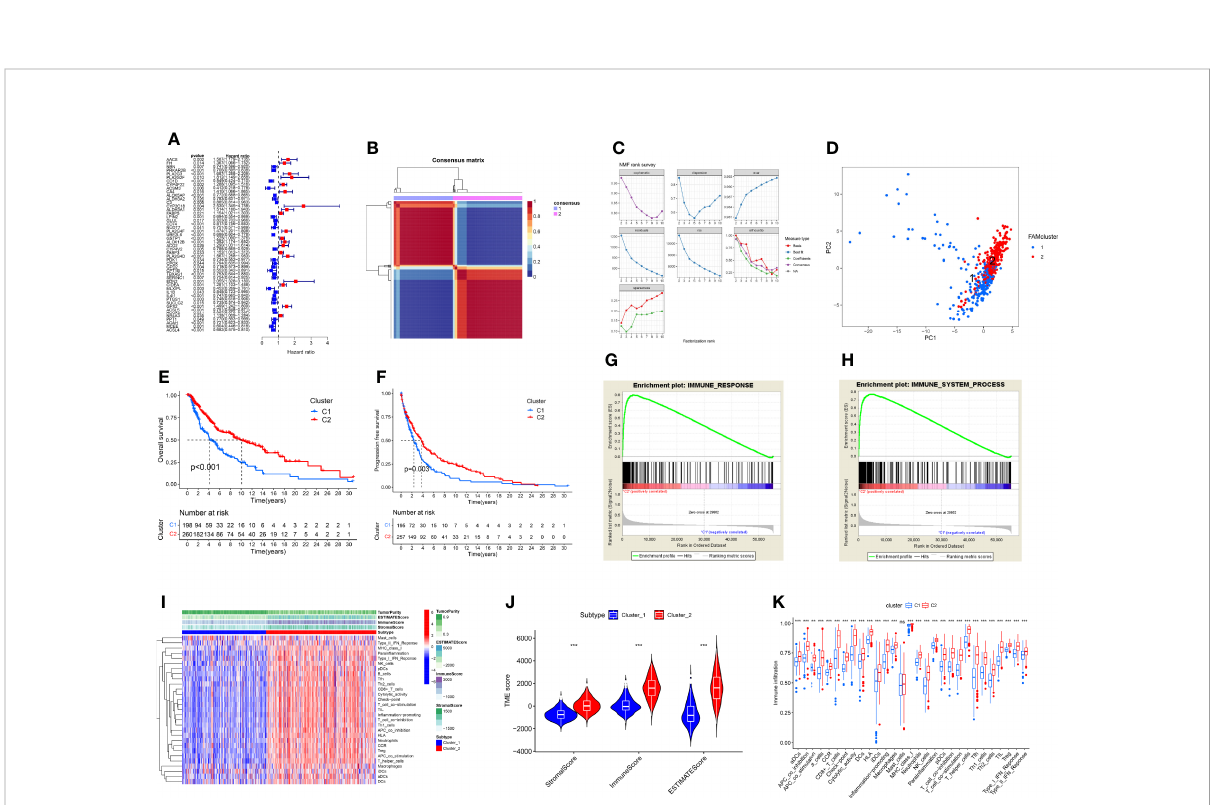
FIGURE 3 Construction of FAM molecular subtypes using TCGA CM samples. (A) A forest map of 49 prognostic FAMGs identi fi ed by univariable Cox regression. (B) The 2 FAM subtypes identi fi ed by the NMF algorithm. (C) The cophenetic, dispersion, and silhouette coef fi cients for the 2 FAM molecular subtypes. (D) Principal component analysis visualization of the 2 FAM molecular subtypes (cluster 1 and cluster 2). (E, F) The OS and DFS of patients with samples in cluster 2 were better than those of patients with samples in cluster 1. (G, H) GSEA results suggest that the immune system process and response pathways are upregulated in cluster 2. (I) Heatmap of TME components in the 2 FAM clusters, showing that cluster 2 had higher level of immune in fi ltrations than cluster 1. (J) Violin plot of TME ESTIMATE scores for the 2 FAM clusters. (K) Differences in immune in fi ltration and function between the 2 FAM clusters, showing immune functions were more activated in cluster 2 than cluster 1. ns, no sigi fi cant, P>0.05; ***P ≤